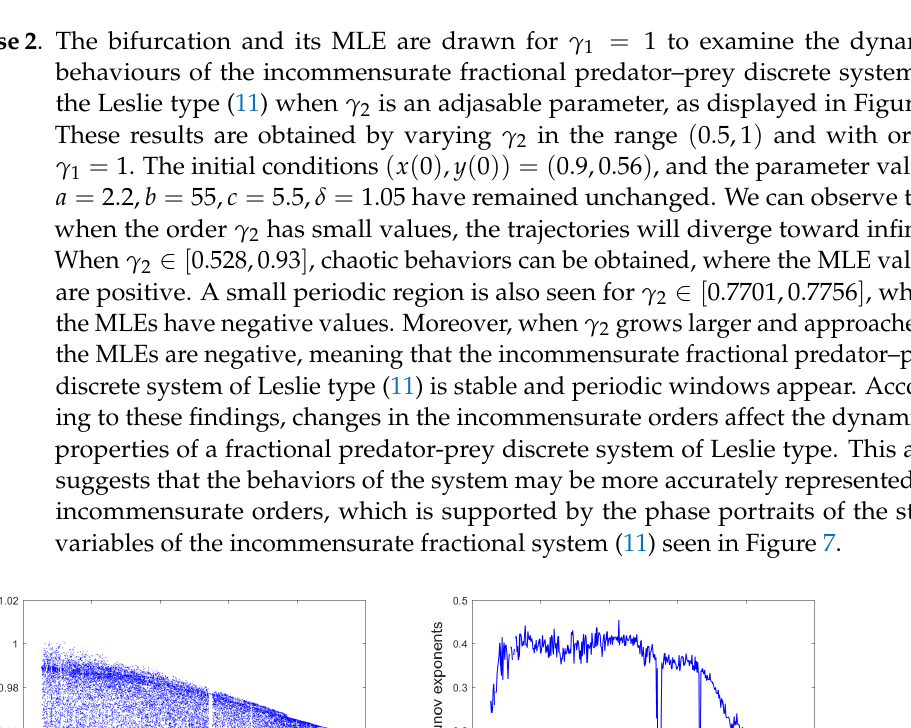
Figure 5. ( a ) Bifurcation of (11) versus γ 1 for a = 2.5, b = 5, c = 5.5, δ = 1.05 and γ 2 = 0.8, ( b ) The corresponding MLE.